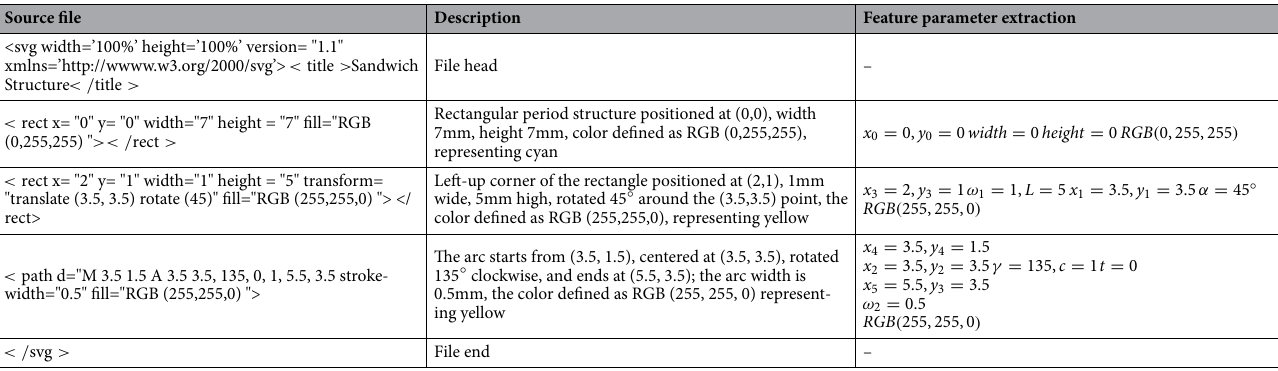
Table 2. SVG format interpretation and parameter extraction.